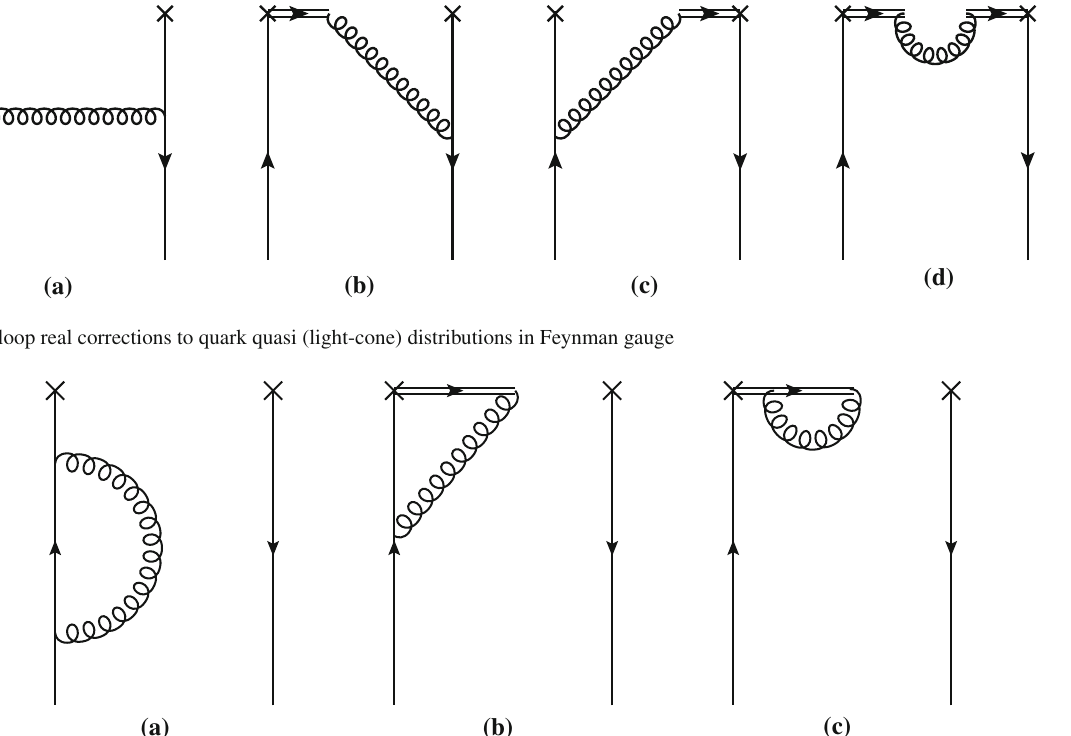
Fig. 5 One-loop virtual corrections to quark quasi (light-cone) distributions in Feynman gauge, where the conjugate diagrams are not